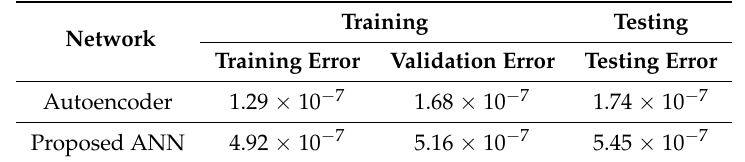
Table 3. Training error, validation error, and testing error of the surrogate model.